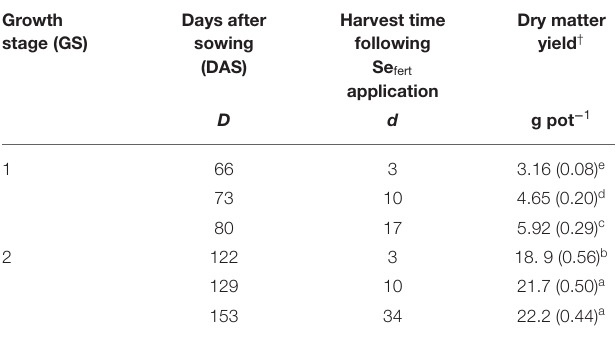
TABLE 2 | The dry matter yield of aboveground plants harvested 3, 10, and 17 days after Se application at stem elongation (GS1) and 3, 10, and 34 days after Se application at the heading stage (GS2) (SE in brackets; n =